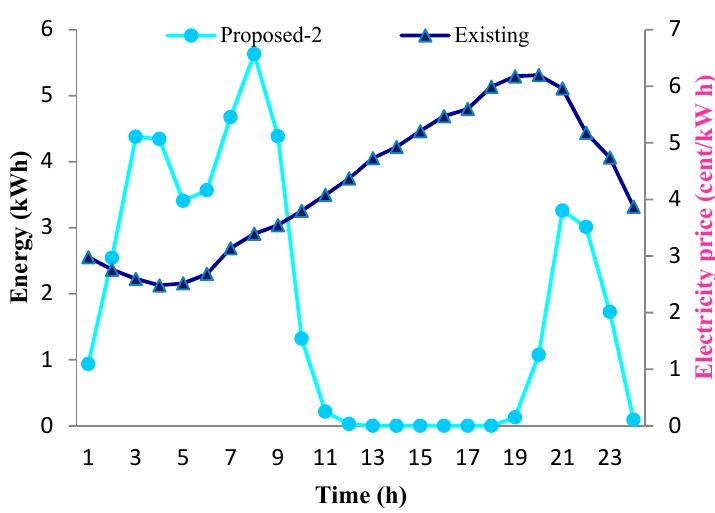
Figure 13. Comparison between proposed-2 and existing scenario of energy and electricity cost management over 24 h time horizon. Table 4. Comparison of the proposed and existing energy, and cost management for case-III.